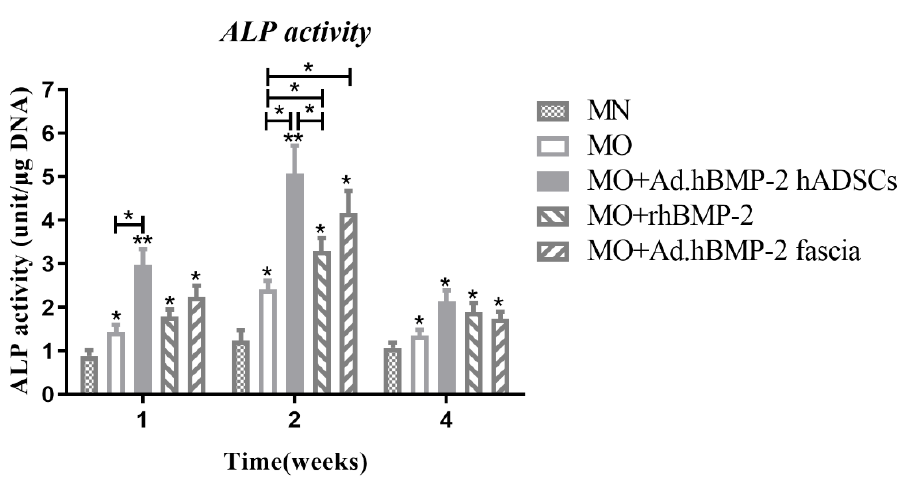
Figure 8. Alkaline phosphatase (ALP) activity analysis at 1 week, 2 weeks and 4 weeks. The significance level of the four MO groups vs. the MN group was marked on the top of column without capped line (* for p < 0.05, and ** for p < 0.01).